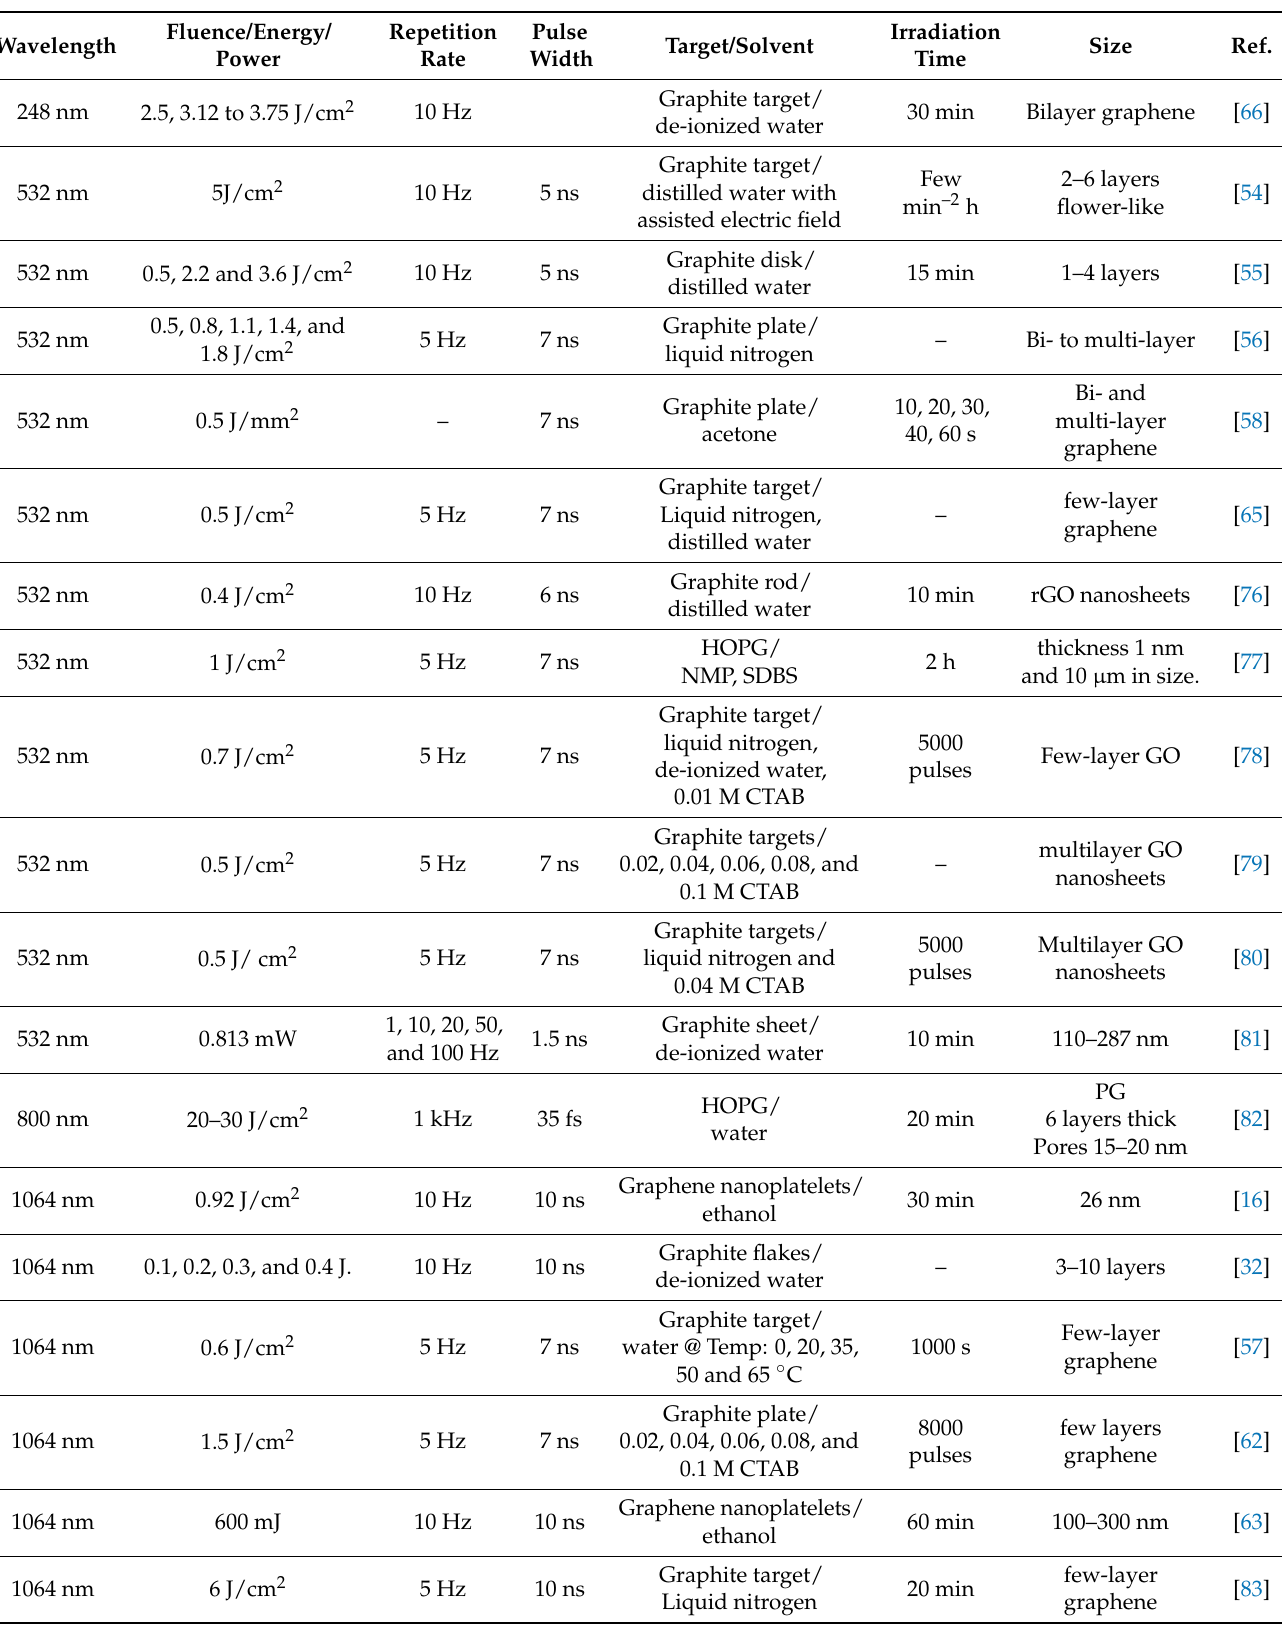
Table 2. Experimental conditions for the fabrication of graphene and graphene-oxide nanosheets via PLAL